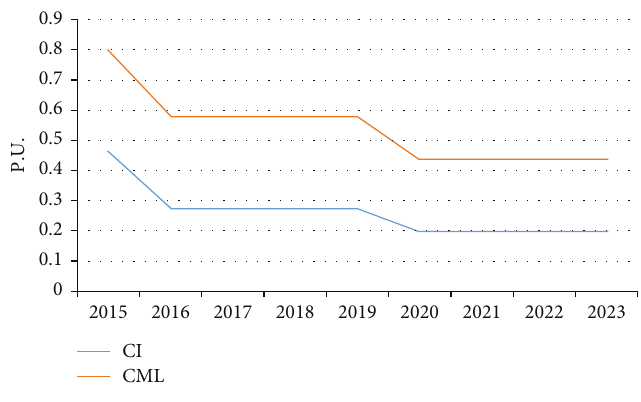
Figure 14: CML and CI; DECC2, 2015 – 2023.